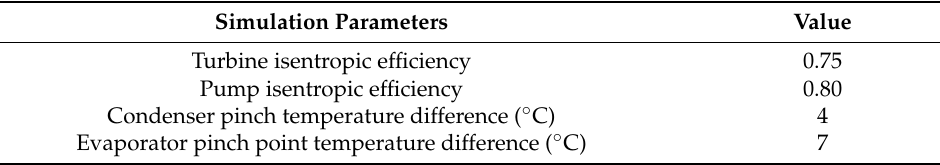
Table 5. Key parameters of the ORC model.